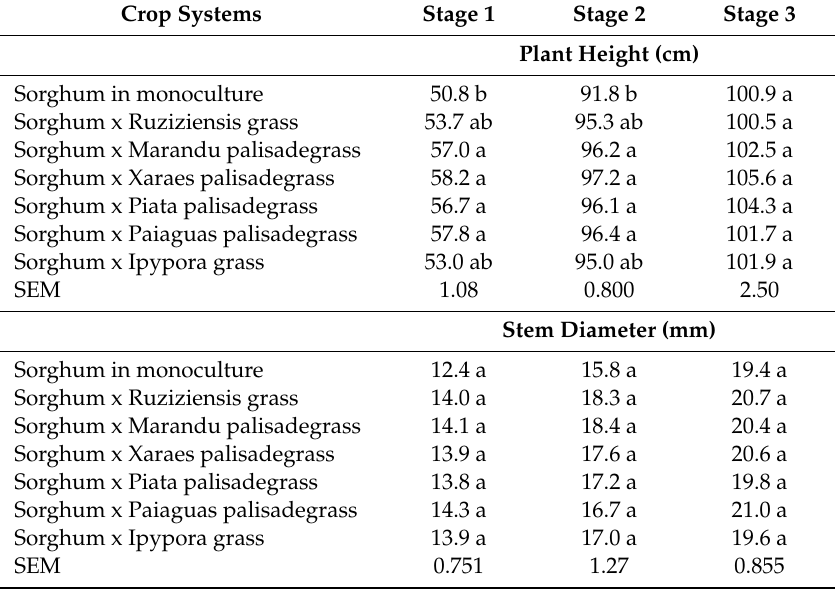
Table 1. Plant height and stem diameter in the vegetative stage (growth stage-GS1, 30 days after sowing (DAS)), reproductive stage (growth stage-GS2, 60 DAS), and grain maturation stage (growth stage-GS3, 90 DAS) of sorghum in monoculture and intercropped with forages of the genus Brachiaria .